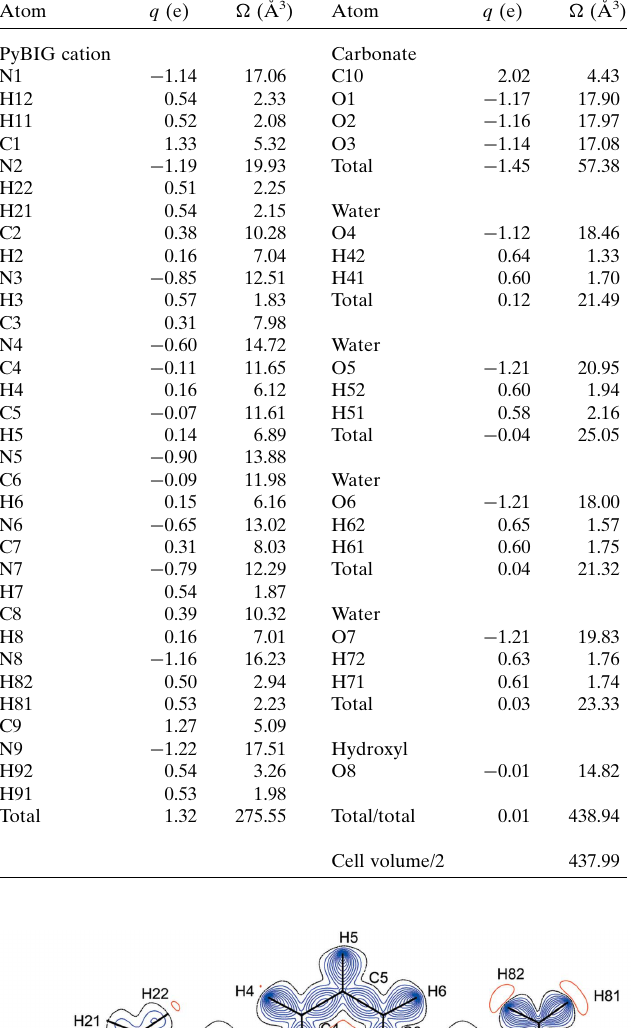
Table 2 Integrated atomic charges ( q ) and volumes ( (cid:3) ).